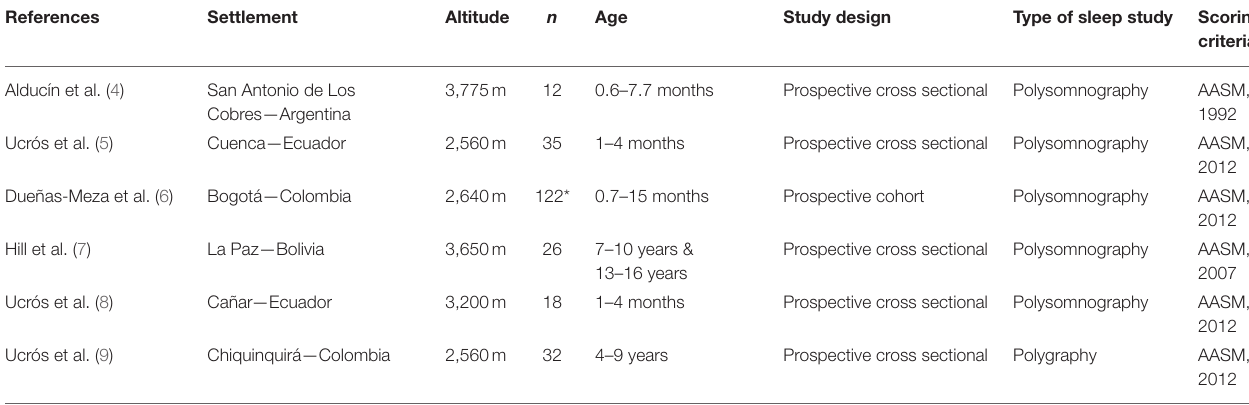
TABLE 1 | Sleep studies in children living at high altitude.